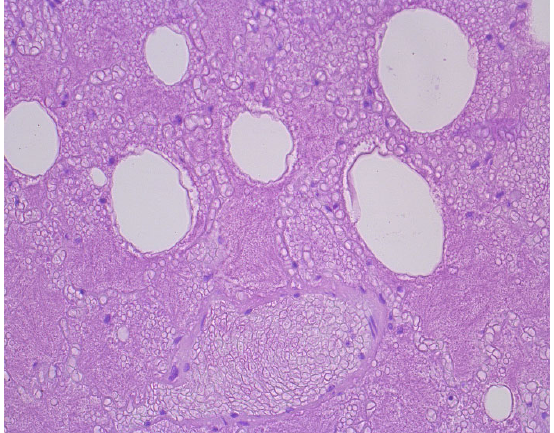
Fig. 15 B. Lungs. Bronchiectasis with a rupture of the wall of the bronchioles. McManus. EP 10, lens